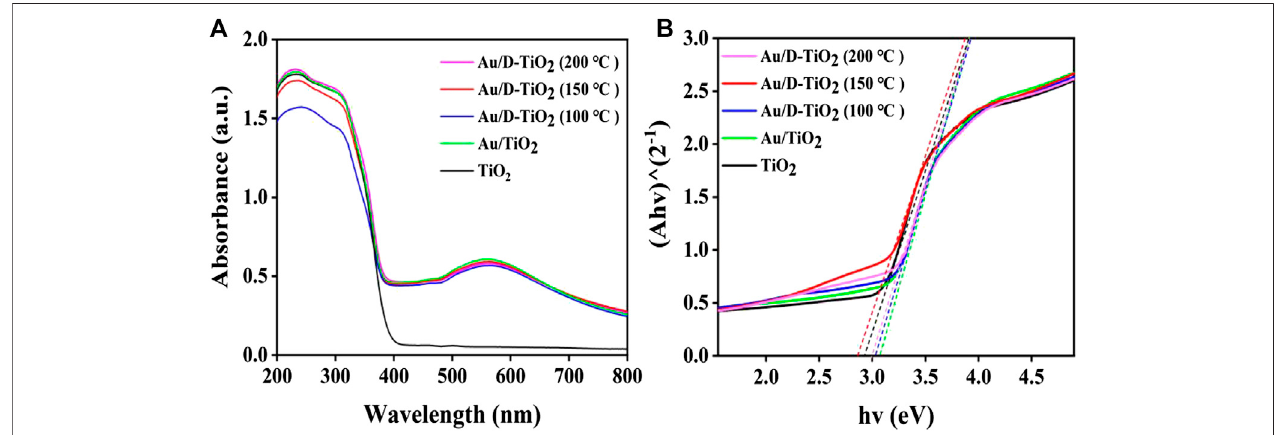
FIGURE4|(A) UV-visDRSofsynthesizedofTiO 2 ,Au/TiO 2 andAu/D-TiO 2 (TheD-TiO 2 weretreatedat100 ° ,150 ° ,and200 ° C,respectively) (B) theforbiddenband width of synthesized of TiO 2 , Au/TiO 2 , and Au/D-TiO 2 (The D-TiO 2 were treated at 100 ° , 150 ° , and 200 ° C, respectively).